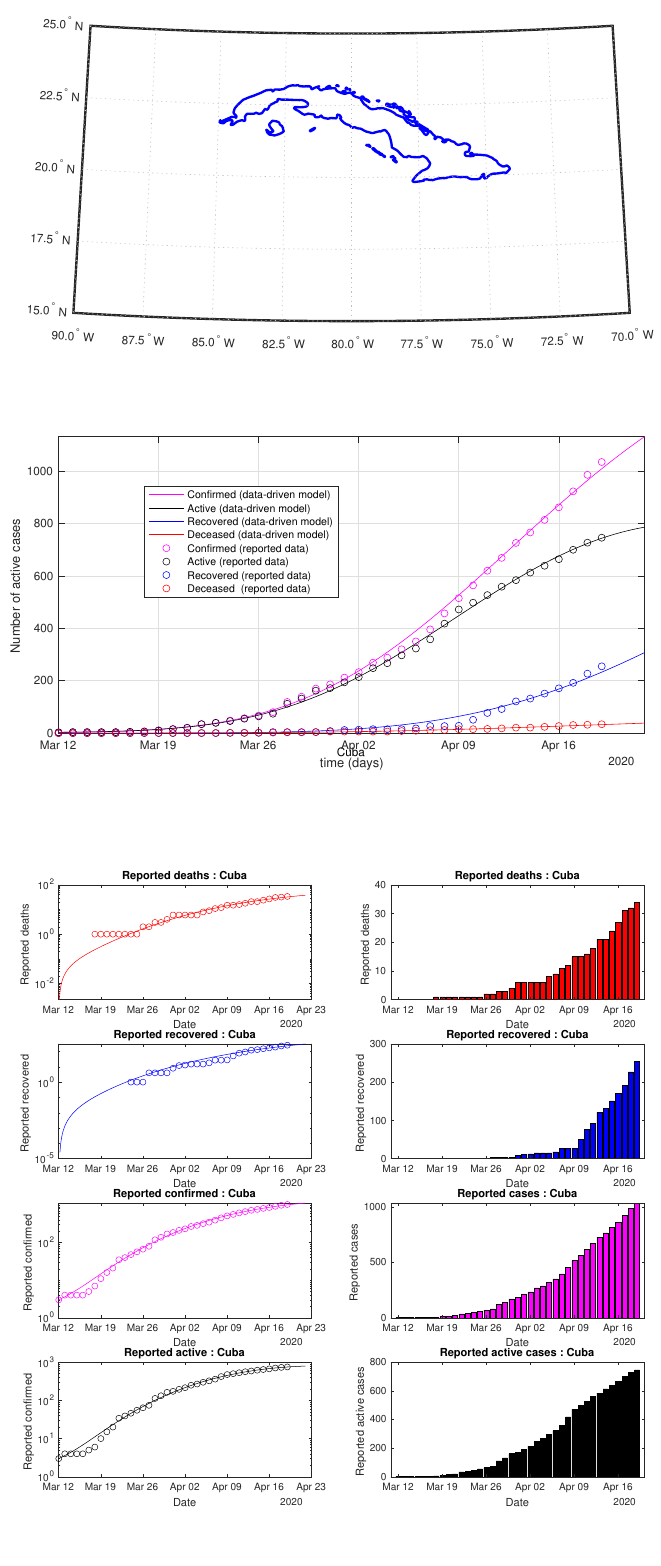
Figure 30. Cuba: data of active, recovered, deceased (in circle or bar) vs. model of active, recovered, deceased over time. Tracking the number of active cases. Predictive analytics for the next couple